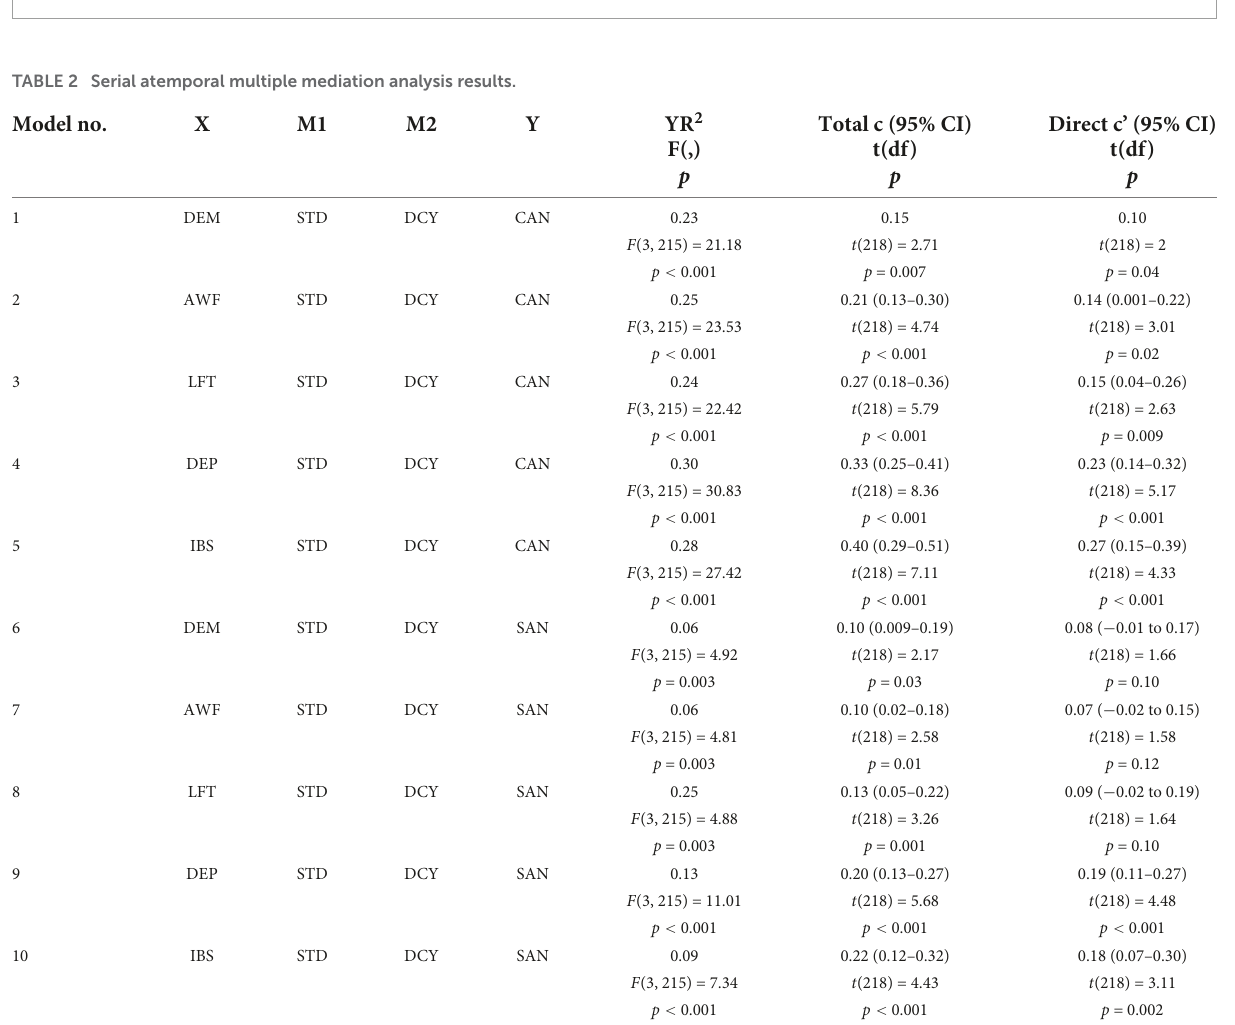
FIGURE1 Serial atemporal multiple mediation model with two mediators. X = independent variable; Y = dependent variable; M 1 , M 2 = mediators; a 1 , a 2 , b 1 , b 2 , d2 1 , c, c (cid:48) = regression coefficients.